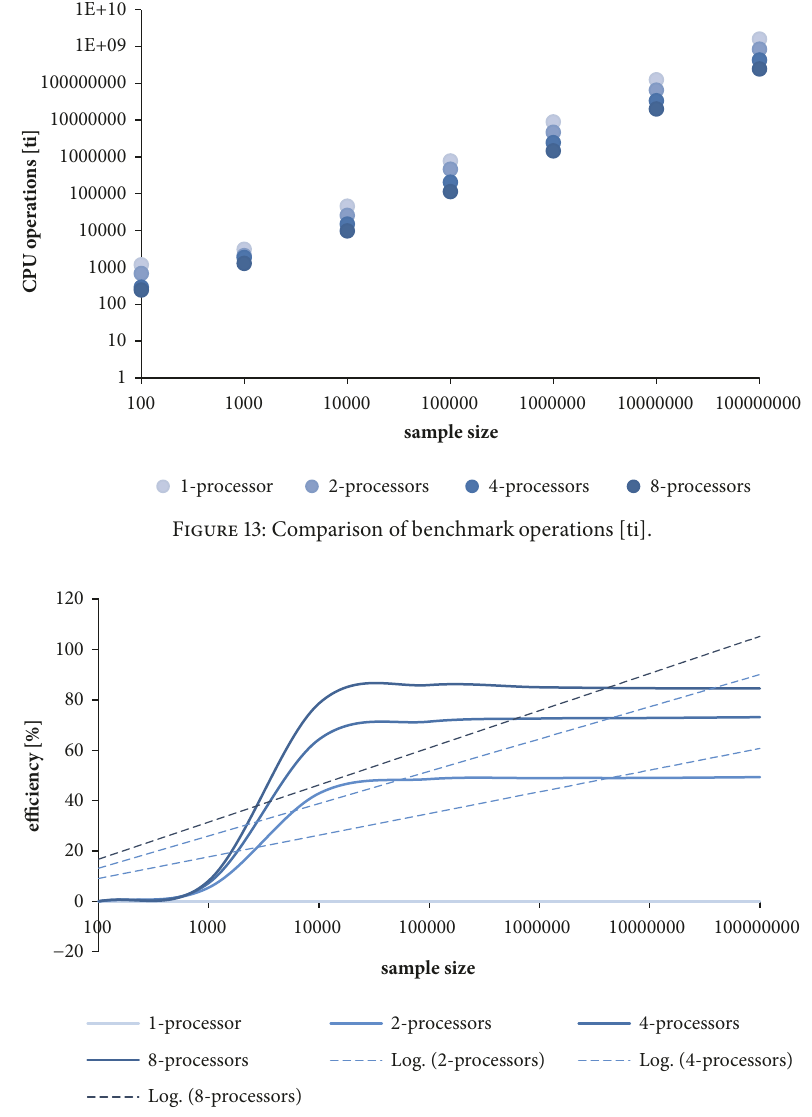
Figure 14: Comparison of the benchmark efficiency using multiple processors in terms of operation time